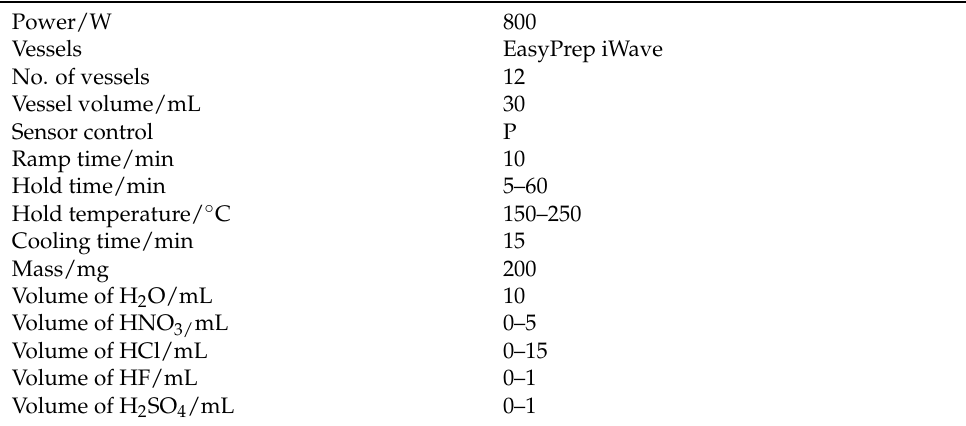
Table 1. Operating parameters, temperature programs and digestion reagents for MARS 6 microwave systems (CEM Corp., Matthews, NC,